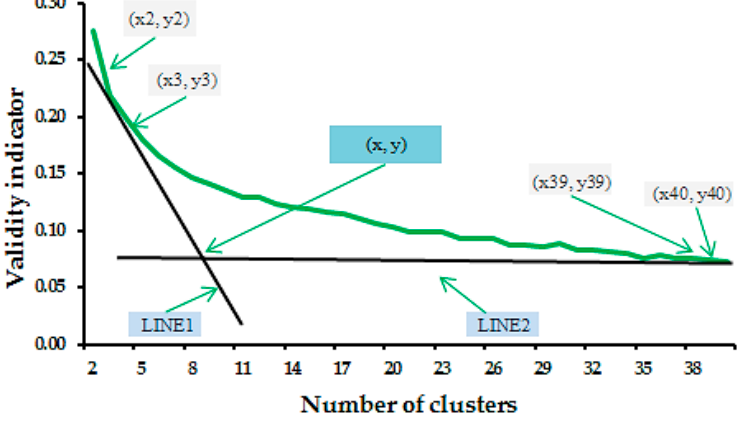
19 of 41 Figure 7. Comparison of the algorithms considering: ( a ) WCBCR, ( b ) IAI, ( c ) SI and ( d ) IEI indicators